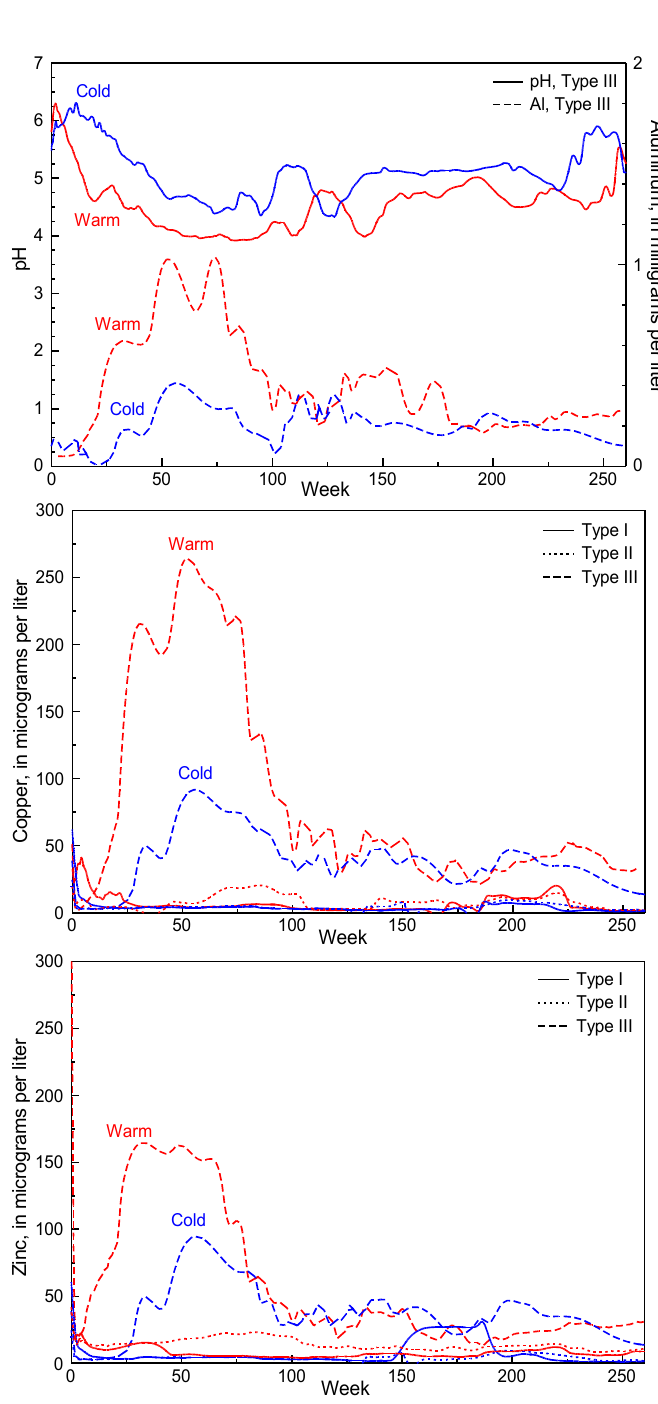
Figure 8. Temporal variation (moving average trendline of a 3-data point window) of pH and Al in leachate from warm and cold humidity cells containing Type III waste rock, and Cu and Zn in leachate from warm and cold humidity cells containing Type I, II, and III waste